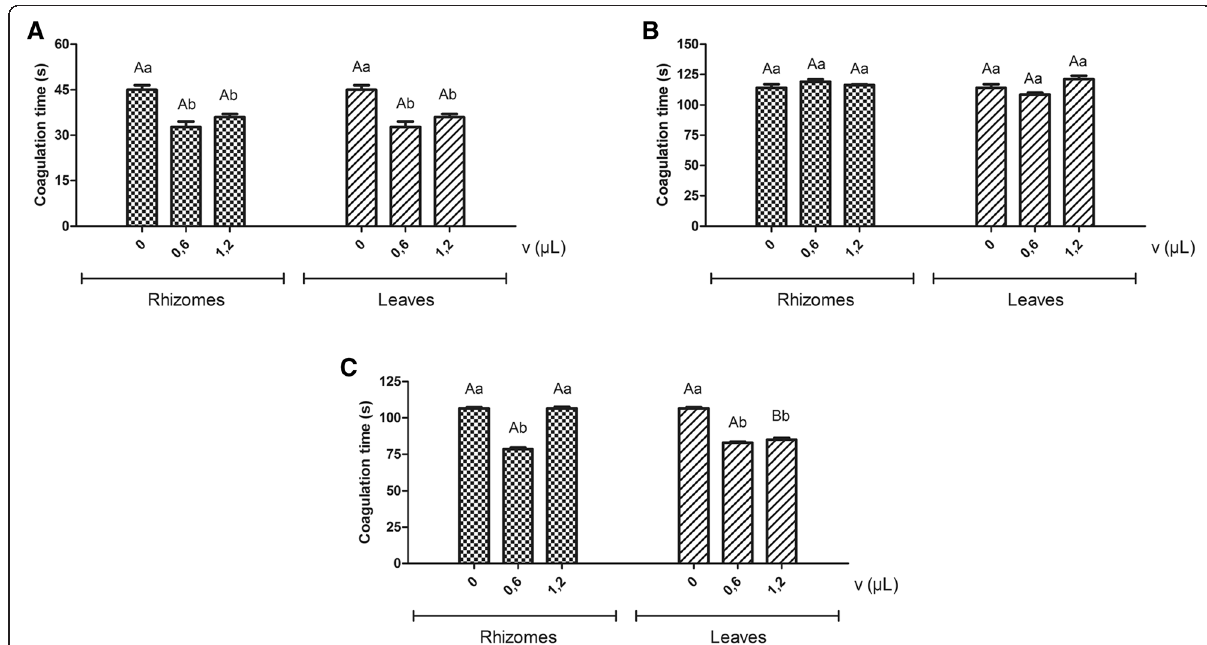
Figure 1 Effect of essential oils on the coagulation of human plasma induced by Bothrops and Lachesis snake venoms after previous incubation of citrated human plasma at 37°C with different volumes of essential oils extracted from rhizomes and leaves of H. coronarium , followed by addition of the venoms of Lachesis muta , B. moojeni and B. atrox (50 μ g/mL). (A) Lachesis muta inducing clotting. (B) Bothrops moojeni inducing clotting. (C) Bothrops atrox inducing clotting. Mean values of the clotting time followed by the same